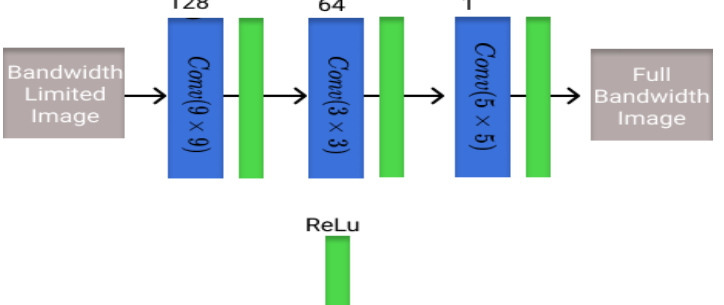
Figure 1. Visualization of the SRCNN architecture utilized in this study with different blocks and the number of filters present in each